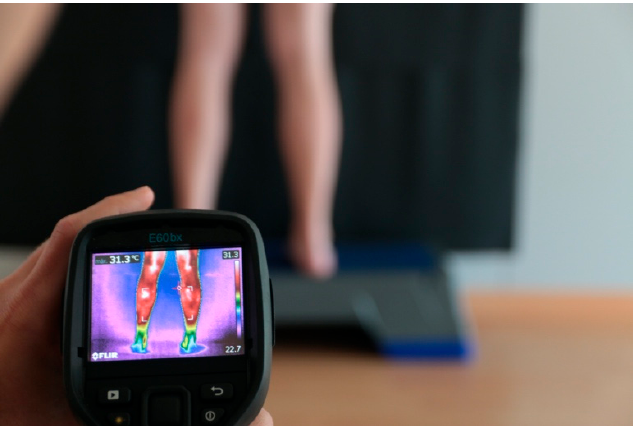
Figure 4. Image capture with FLIR E60. Prepared by the